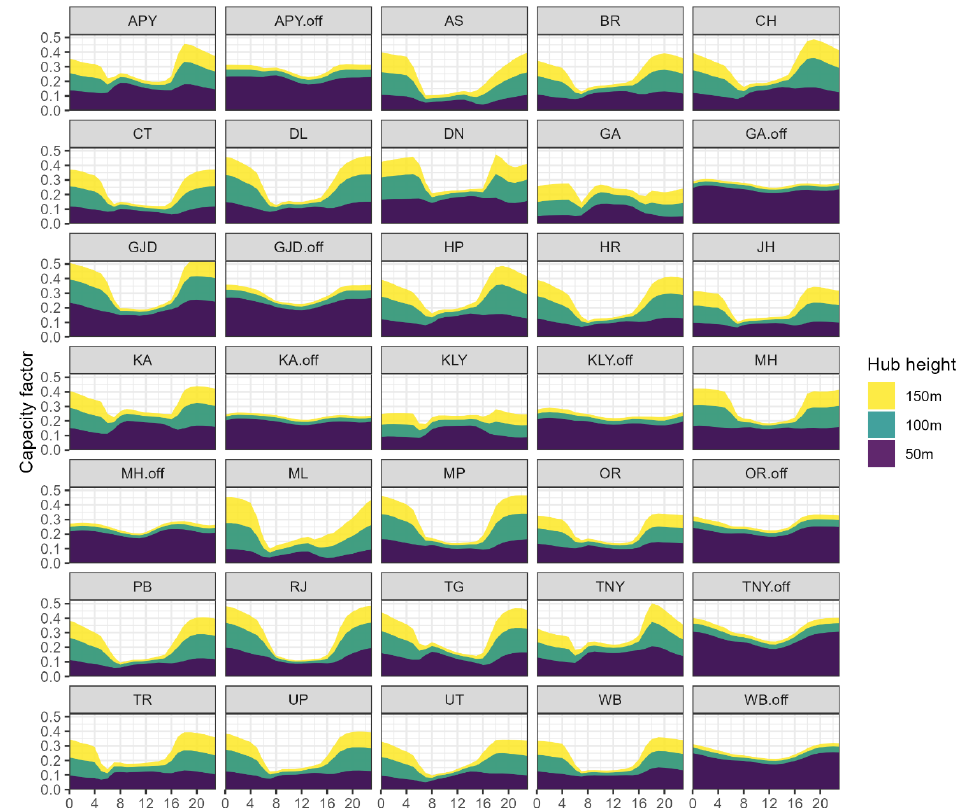
Figure A3. Annual average wind power capacity factor profiles, based on MERRA-2 data (50 m) and extrapolated (100 m and 150 m) with dynamic Hellmann constant (using 10 m and 50 m MERRA-2 data).